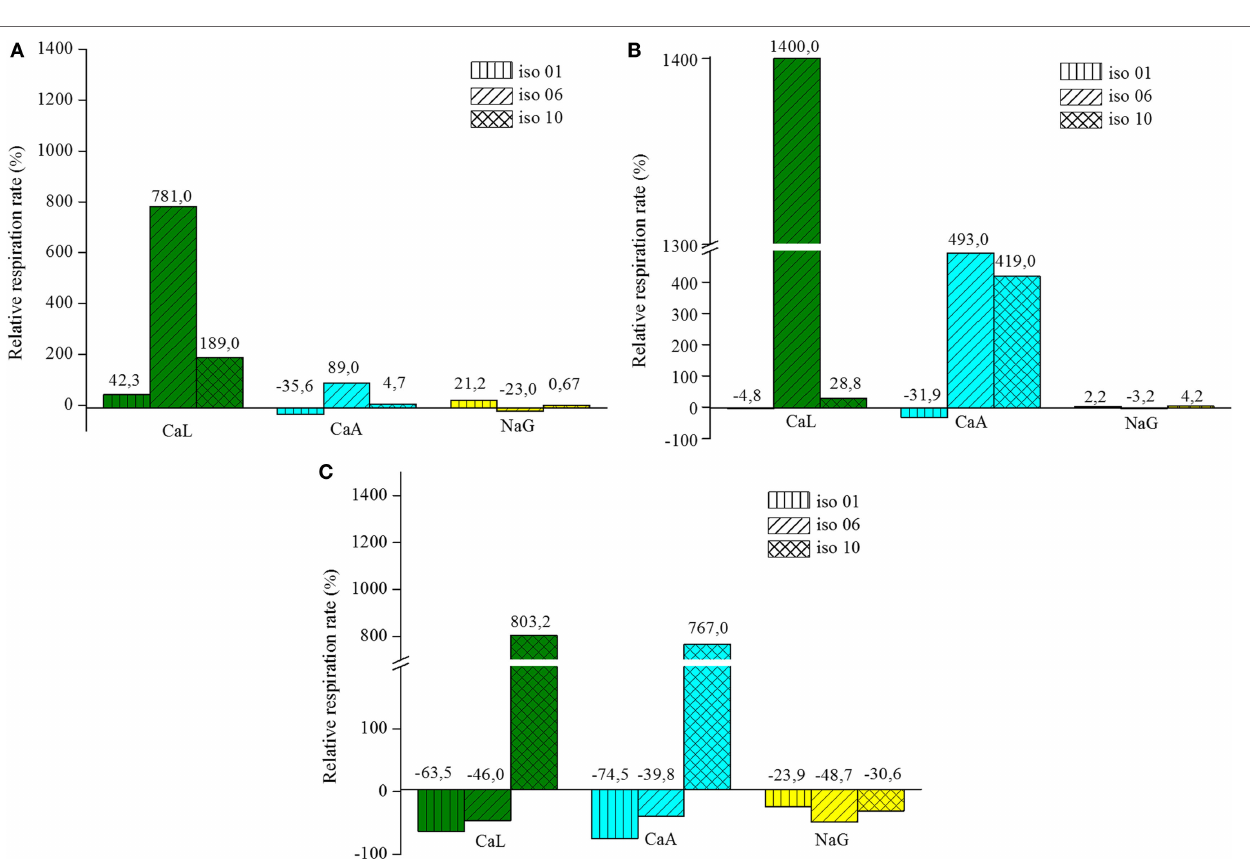
FigUre 3 | Relative respiration rate of vegetative cells pre-grown in: (a) lactate, (B) acetate, and (c) gluconate.